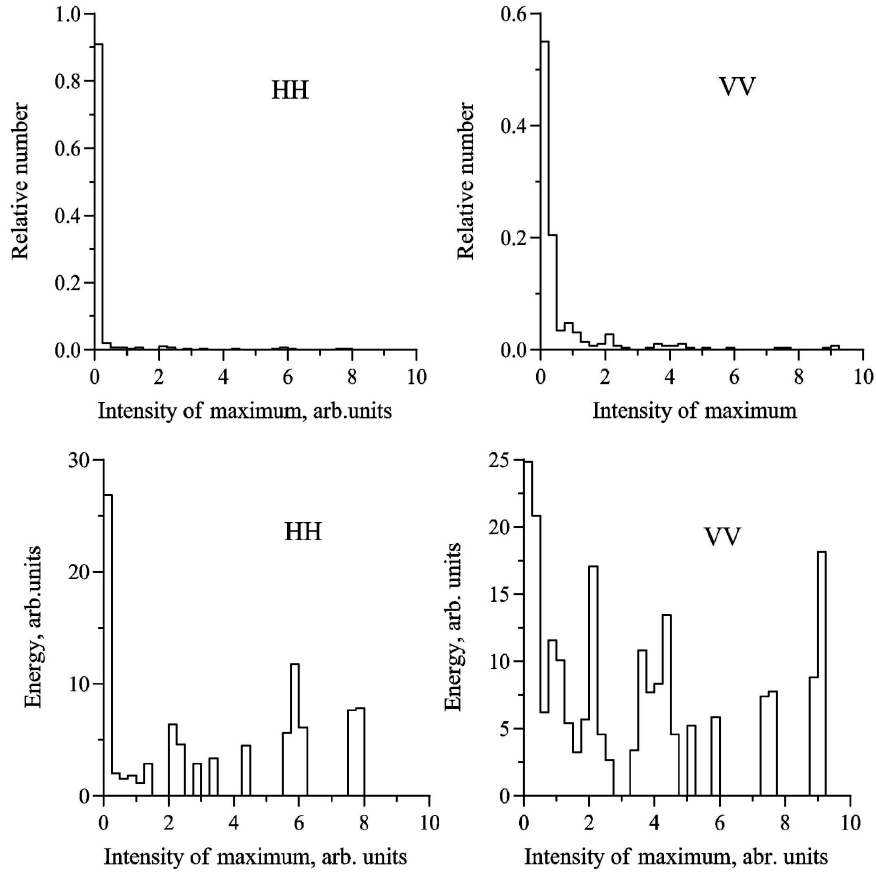
Figure 9. Same as in Figure 8 but for slicks. Wind velocity is 10 m/s, incidence angle of